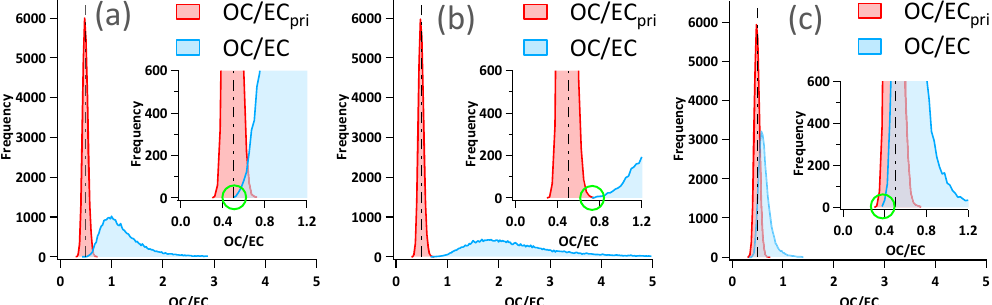
Figure 3. Conceptual diagram illustrating three scenarios of the relationship between (OC / EC) pri and ambient OC / EC measurements. Both are assumed to be log-normally distributed. (a) Ambient minimum (left tail) is equal to the peak of (OC / EC) pri . (b) Ambient minimum OC / EC (left tail) is larger than the mean of (OC / EC) pri . (c) Ambient minimum OC / EC (left tail) is less than the peak of (OC / EC) pri .